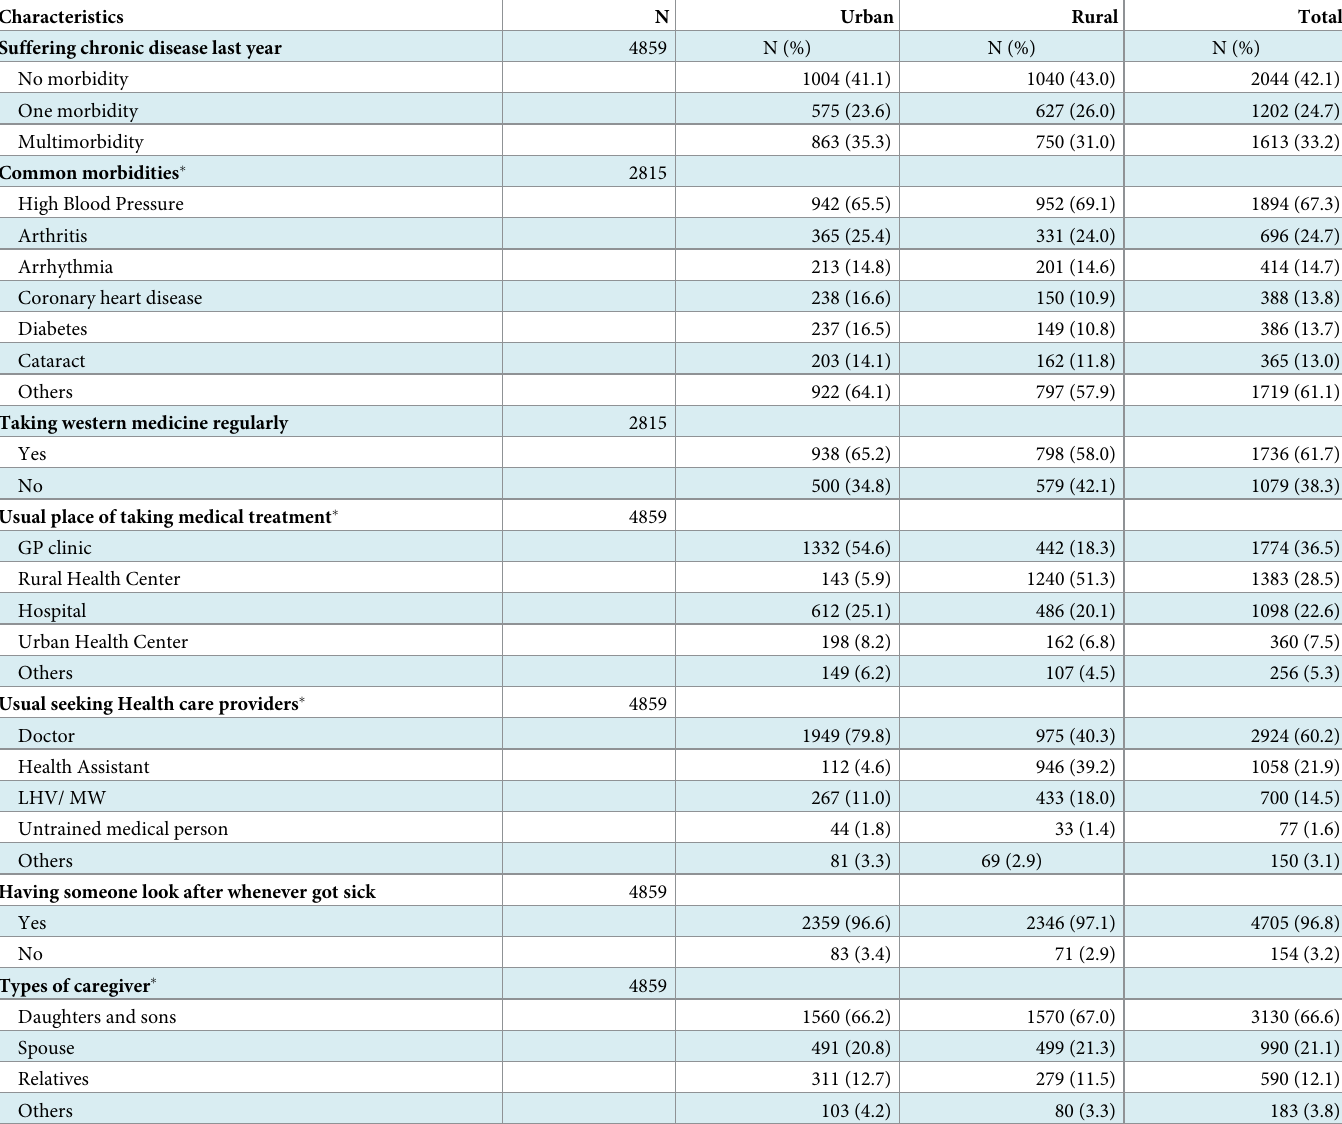
Table 3. Morbidity and health seeking behaviours of older study participants.